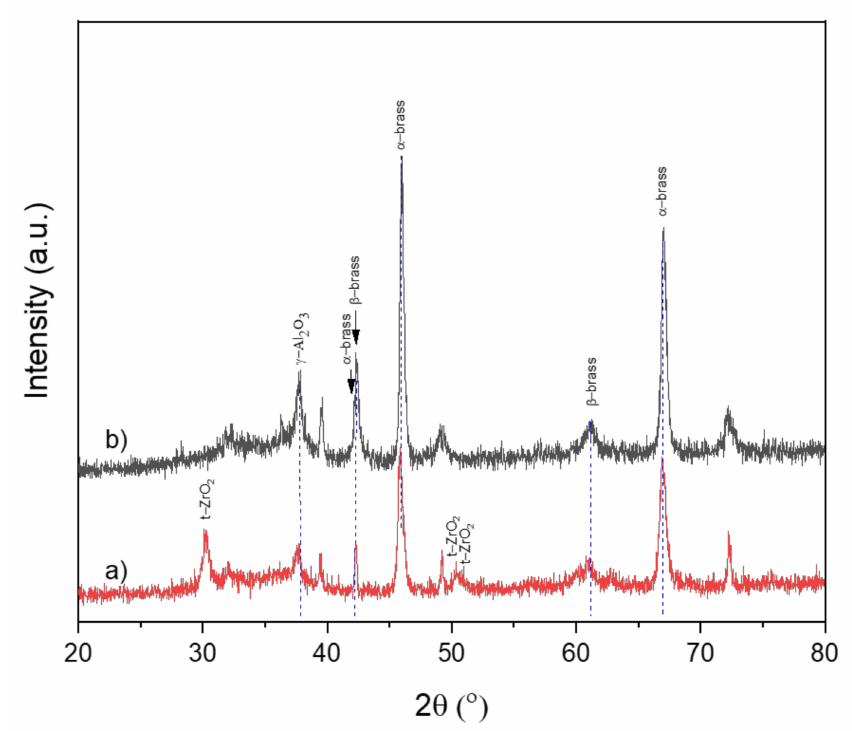
Figure 7. XRD pattern of ( a ) Al 2 O 3 /SiO 2 -ZrO 2 composite coating deposited on brass substrate annealed at 850 ◦ C; ( b ) Al 2 O 3 interlayer on brass substrate.